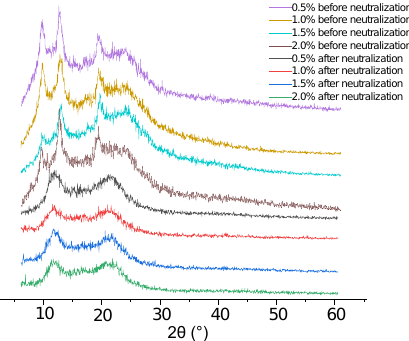
Figure 6. Effects of chitosan concentration on XRD diffractograms of chitosan films before and after neutralization.